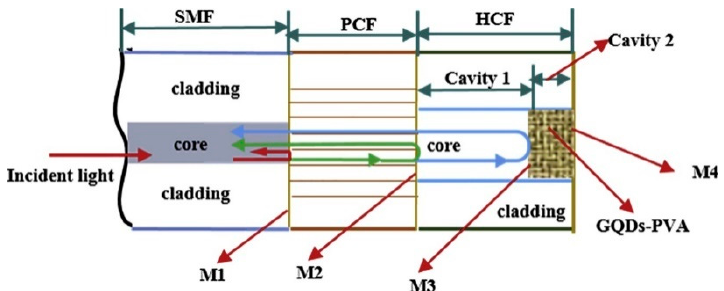
Figure 18. The structure of the FP interferometer constructed by splicing a section of an SC-PCF between a section of SMF and a section of HC-PCF. Reprinted with permission from [121].